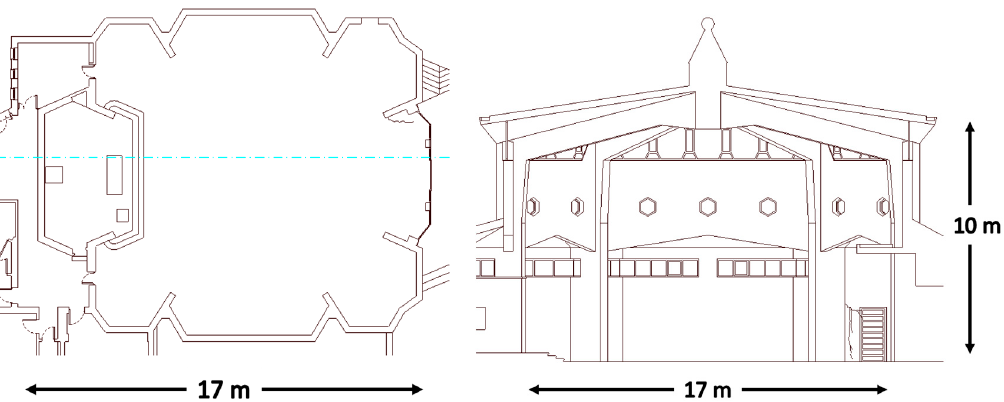
Figure 2. Ground plan and section of the church.